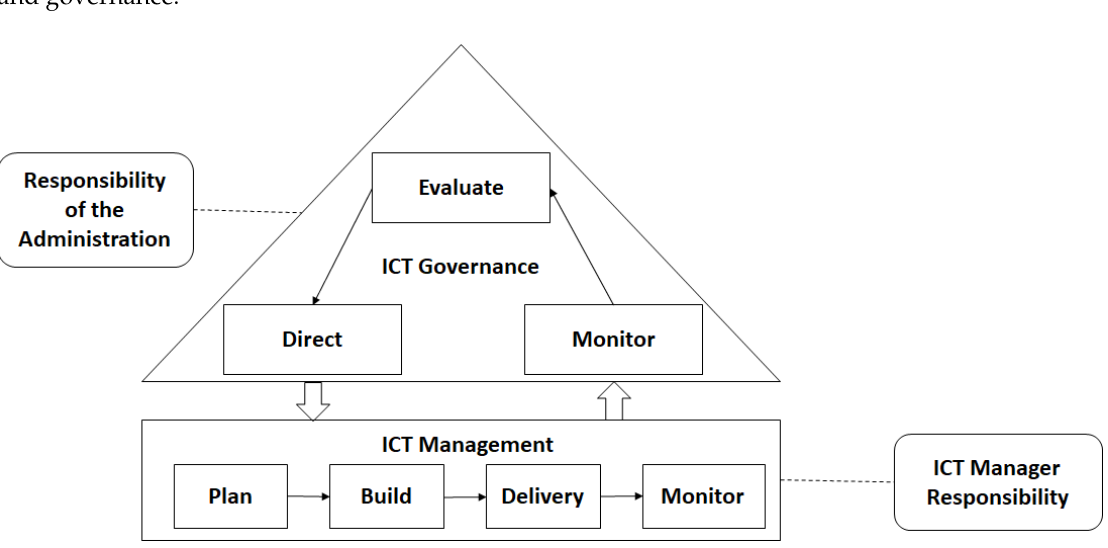
Figure 2. ICT management tasks and their relation to ICT governance. Source: ISO/IEC 38500 2009